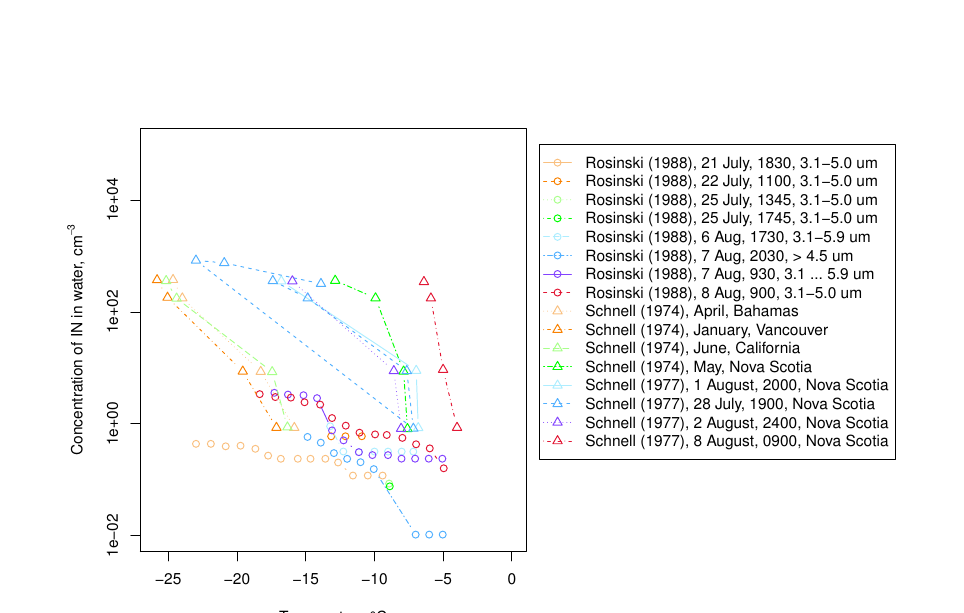
Fig. A1. Ice nucleation spectra of particles separated from sea water by filtration. Rosinski et al. (1988) data (circles) are from the Gulf of Mexico, and IN concentrations were determined by condensation-followed-by-freezing using the dynamic developing chamber of Langer and Rodgers (1975). Results from (Schnell and Vali, 1975) (triangles) are from various locations as indicated, IN concentrations were determined using a drop freezing assay (immersion freezing).